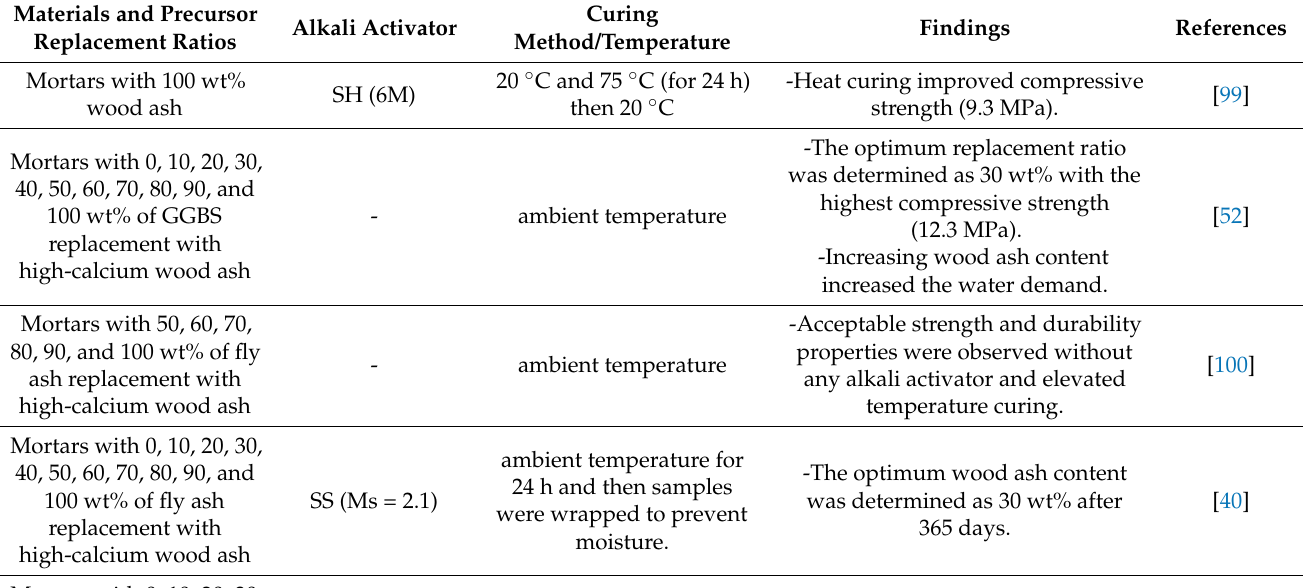
Table 3. Alkali activators, curing methods, or temperature of alkali-activated materials with wood